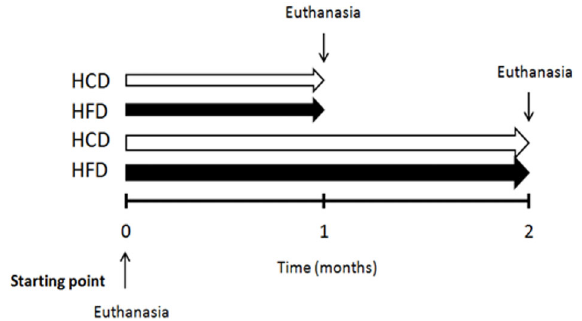
Figure 1. Experimental design. All mice received standard rodent chow before starting (time 0) and a high-fat diet (HFD) or a high- carbohydrate diet (HCD) was administered for 1 or 2